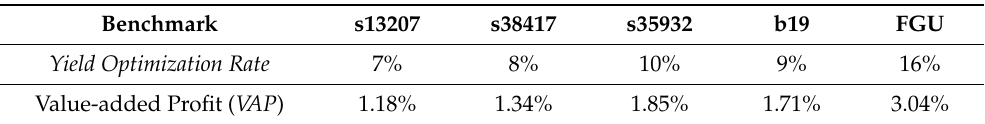
Table 1. The Yield Optimization Rate and Value-Added Profit ( VAP ) with the proposed adaptation on various